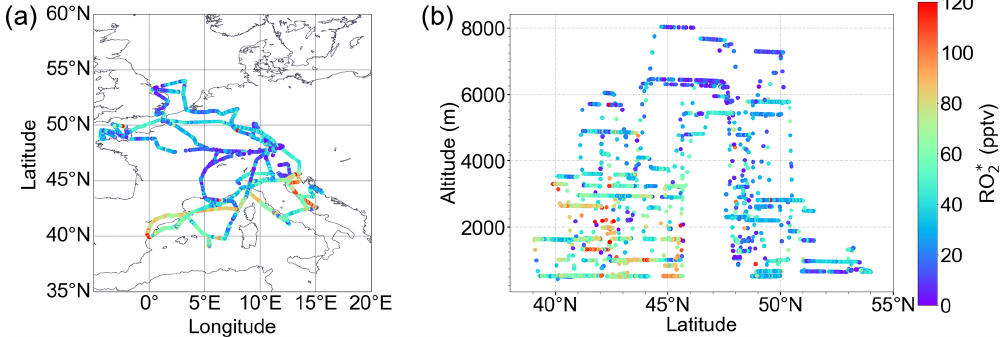
spatial and vertical distribution measured along all EMeRGe flights in Europe. Figure 34. RO ∗ 2